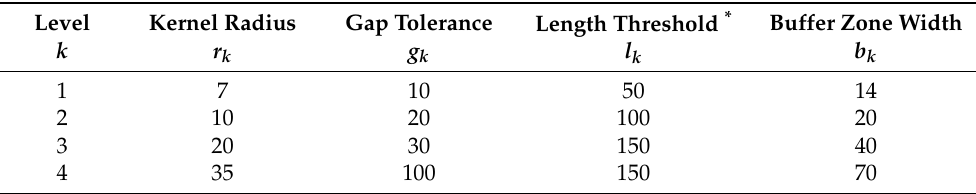
Table 4. The multi-level parameter settings in the structuralization of the braided river network in the Mobile–Tensaw River